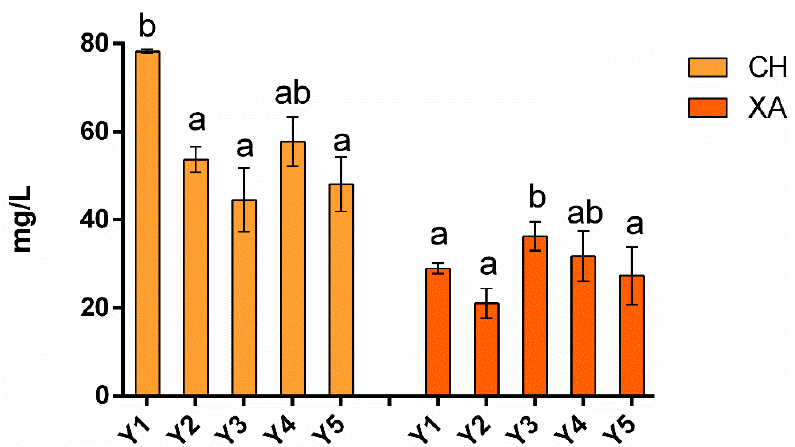
Figure 1. Total protein content base wines of Chardonnay (CH) and Xarel.lo (XA) elaborated with the addition of different S . cerevisiae (Y1, Y2, Y3) and non- Saccharomyces yeasts, M. pulcherrima (Y4) and T. delbrueckii (Y5). Different letters indicate significant differences between samples with different yeasts for each variety, Chardonnay (CH) and Xarel.lo (XA). Samples (n = 2). Table 2. Analysis of the protein profile by SDS-PAGE and quantification in terms of the percentage of protein bands fractions (%) by detecting their molecular weights (MW), of the base wine of Chardonnay (CH) and Xarel.lo (XA) elaborated with different yeast strains: Saccharomyces cerevisiae (Y1, Y2, Y3) and non-Saccharomyces, M. pulcherrima (Y4) and T. delbrueckii